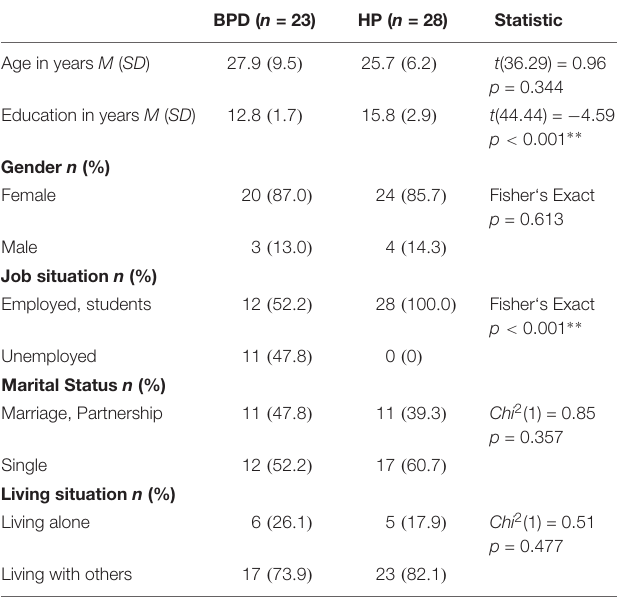
TABLE 1 | Sociodemographic data for BPD patients and healthy participants